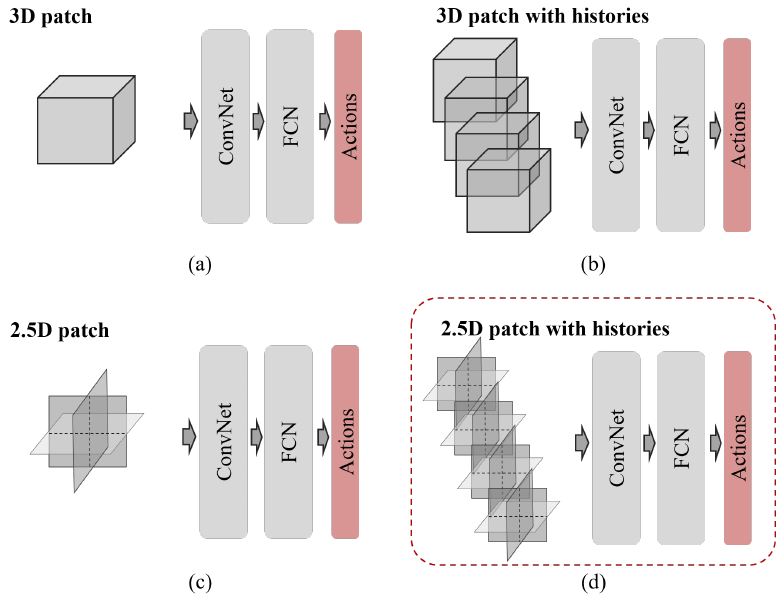
Figure 1. Various state representations: ( a ) single 3D boxed patch, ( b ) 3D patch with multiple histories, ( c ) 2.5D patch with three orthogonal view aggregation, and ( d ) 2.5D patch with multiple histories, with the state used in this study; ConvNet, convolutional neural network; FCN, fully connected